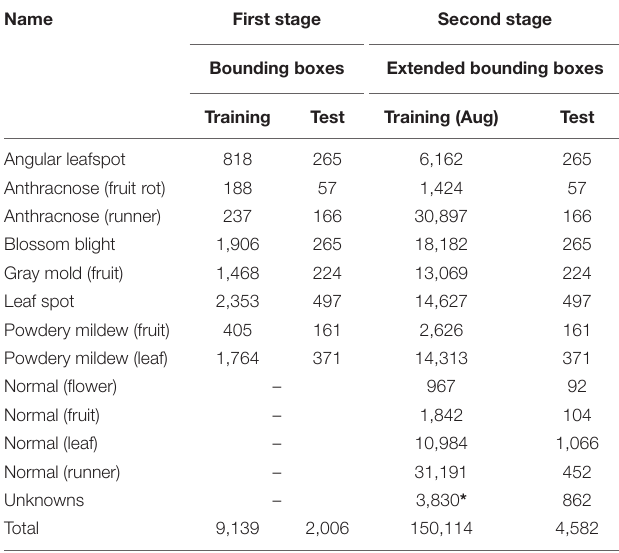
TABLE 2 | Number of bounding boxes for the training and testing of disease